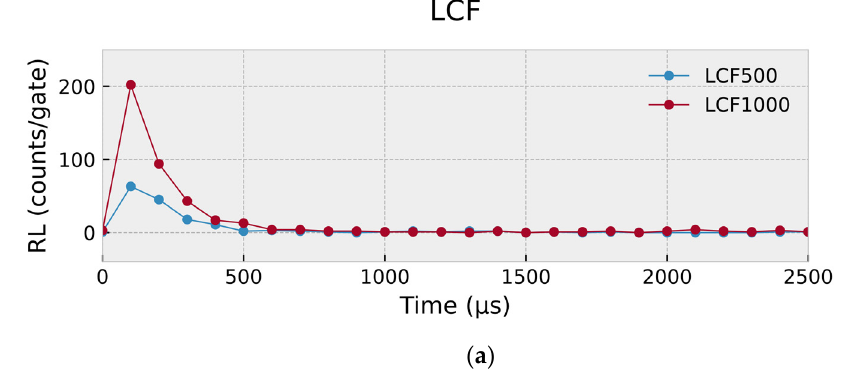
structed from data collected with a gate time of 1 µ s. The reference trace, from the PMMA fiber, corresponds to the stem effect as acquired from a bare PMMA without an attached